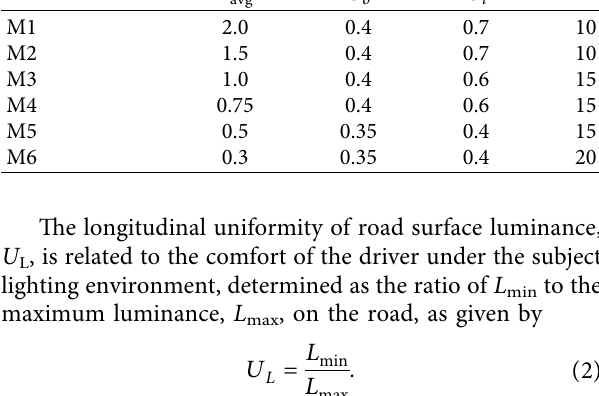
Table 1: CIE standards for street lighting [6, 22]. Lighting